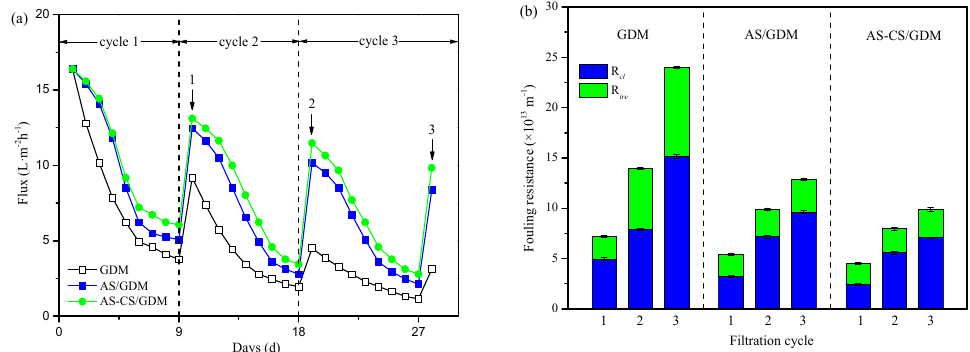
Figure 2. ( a ) Flux decline and ( b ) fouling resistance distributions in three systems. Note: AS = aluminum sulfate; CS = chitosan.